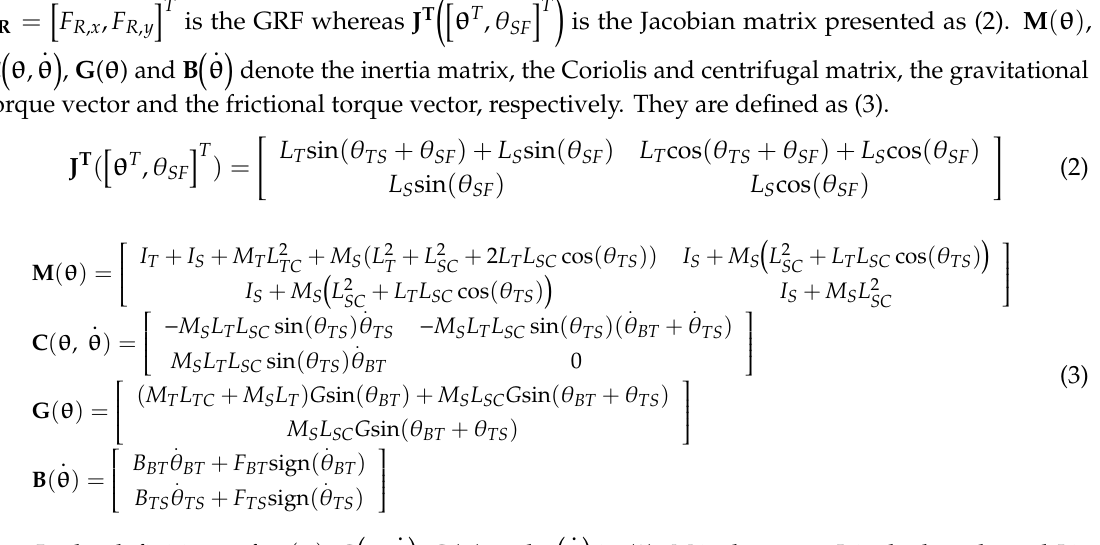
Table 1. Identified parameter values of the right leg.